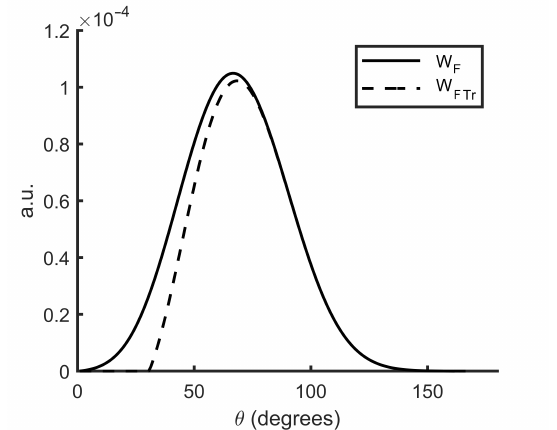
Figure 9. Comparison between the angular weighting function ( W f ) and the truncated angular weighting function as a function of the scattering angle ( θ